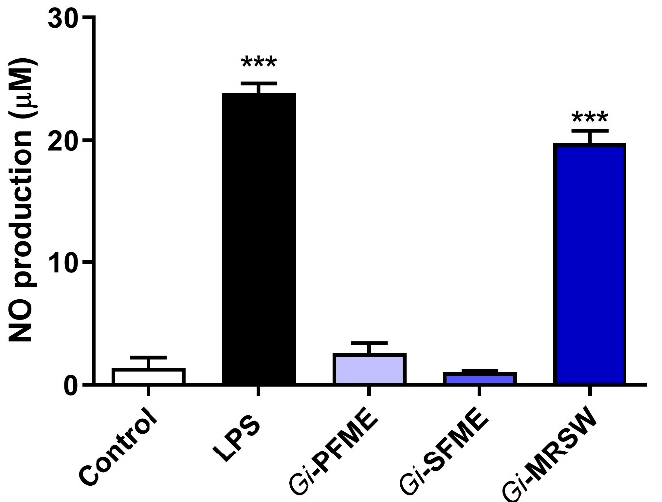
Figure 1. NO production determined based on the amount of nitrite by the Griess reaction. RAW264.7 cells were treated with LPS (200 ng/mL) or polysaccharides ( Gi -PFME, Gi -SFME, and Gi -MRSW) at 40 µg/mL for 24 h. The culture medium was collected and analyzed for nitrite levels. *** p < 0.001 according to ANOVA followed by a Dunnett’s multiple comparison post-test.